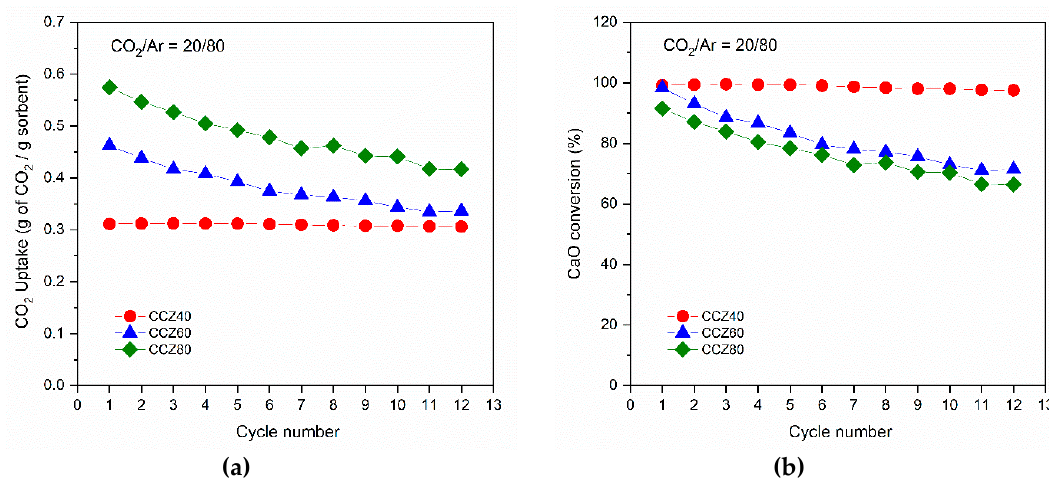
Figure 6. Stability and performance tests of CCZ samples under mild conditions showing the CO 2 uptake over 12 carbonation/calcination cycles ( a ) and the calculated CaO conversion ( b ).